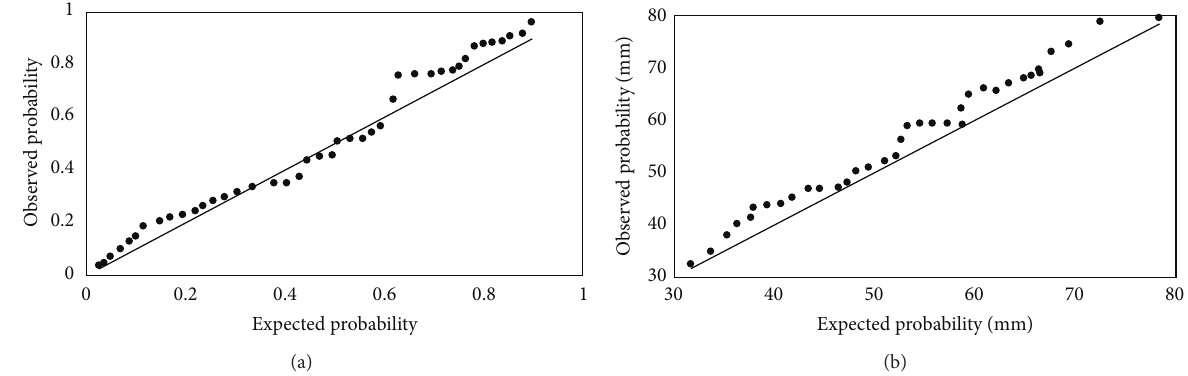
Figure 5: Probability plot (a) and quantile-quantile plot (b) for Xinjiang, Model 1.